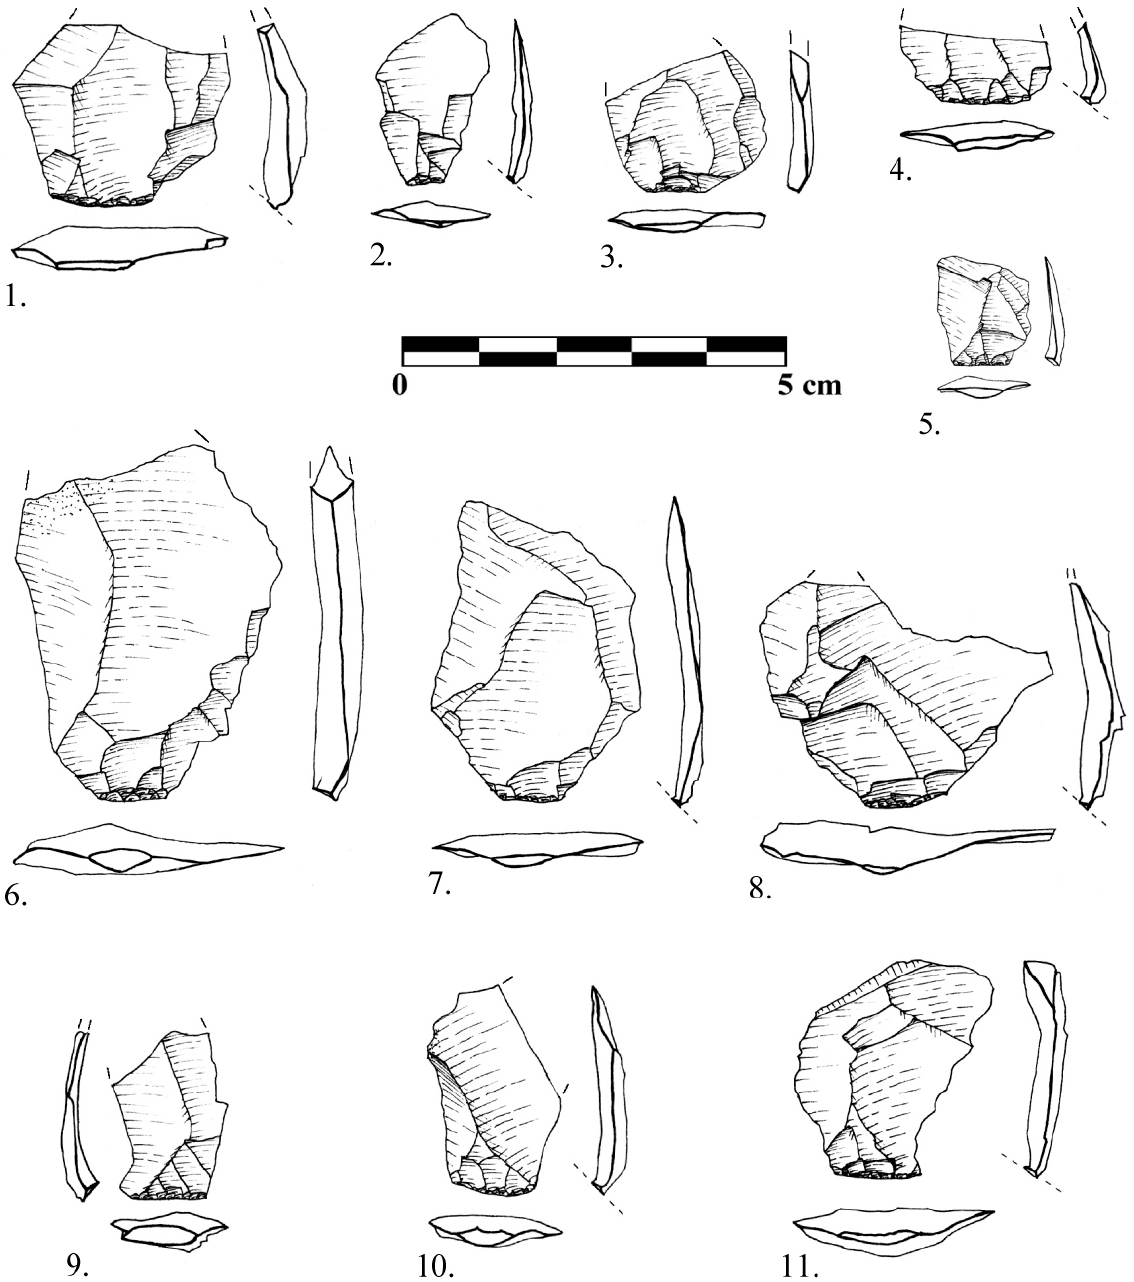
Figure 4. Eclats de raffûtage latéral de pièces façonnées unifacialement détachés par percussion marginale. Tous ces éclats présentent un lustre d’utilisation identifiable à l’œil nu au niveau de la ligne de séparation entre le talon et la face supérieure. Figure 4. Lateral resharpening flakes from unifacially shaped artefacts removed by marginal percussion. Every flake presents a use luster visible to the naked eye in the line between the butt and the external